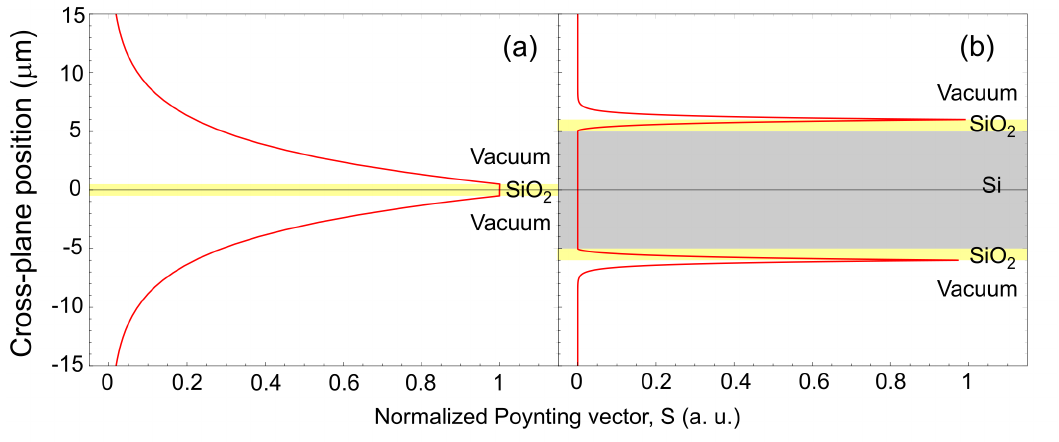
Figure 7. Normalized Poynting vector along the cross-plane direction for ( a ) the single SiO 2 film and ( b ) the three-layer structure surrounded by